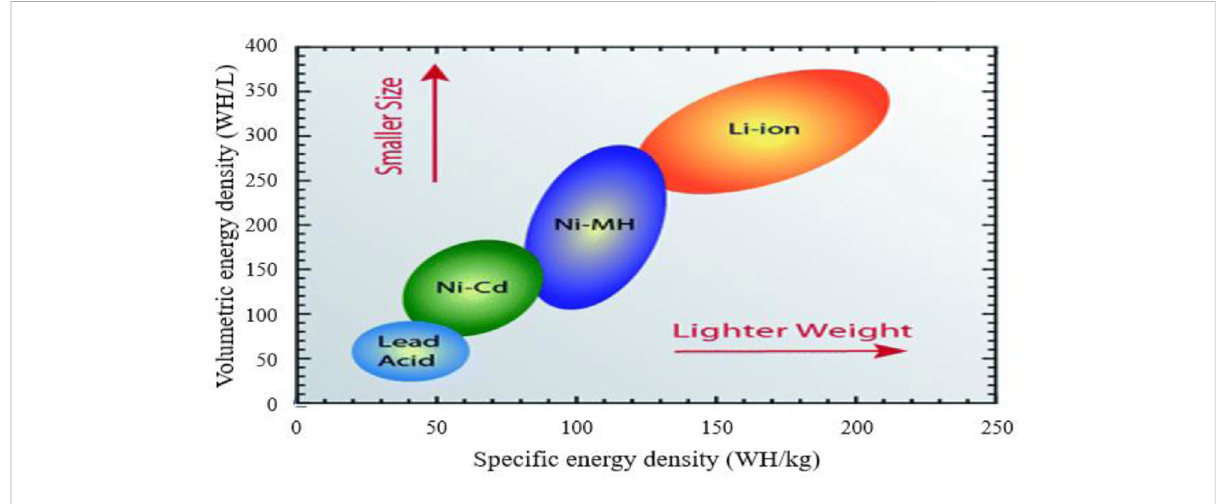
FIGURE 5 Energy densities in batteries.